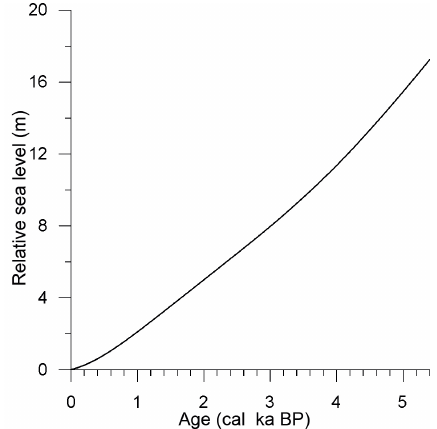
Figure 2. Changes of relative sea level in the study area over the last 5.4ky based on the empirical model by Påsse and Anders- son